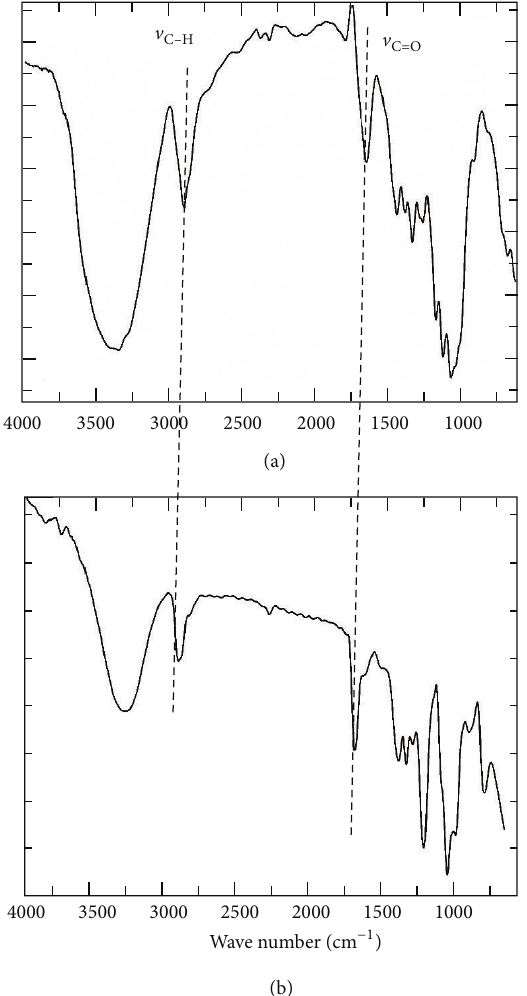
Figure 2: FTIR spectra of (a) jute cellulose crystals and (b) CC-PLA biocomposite.